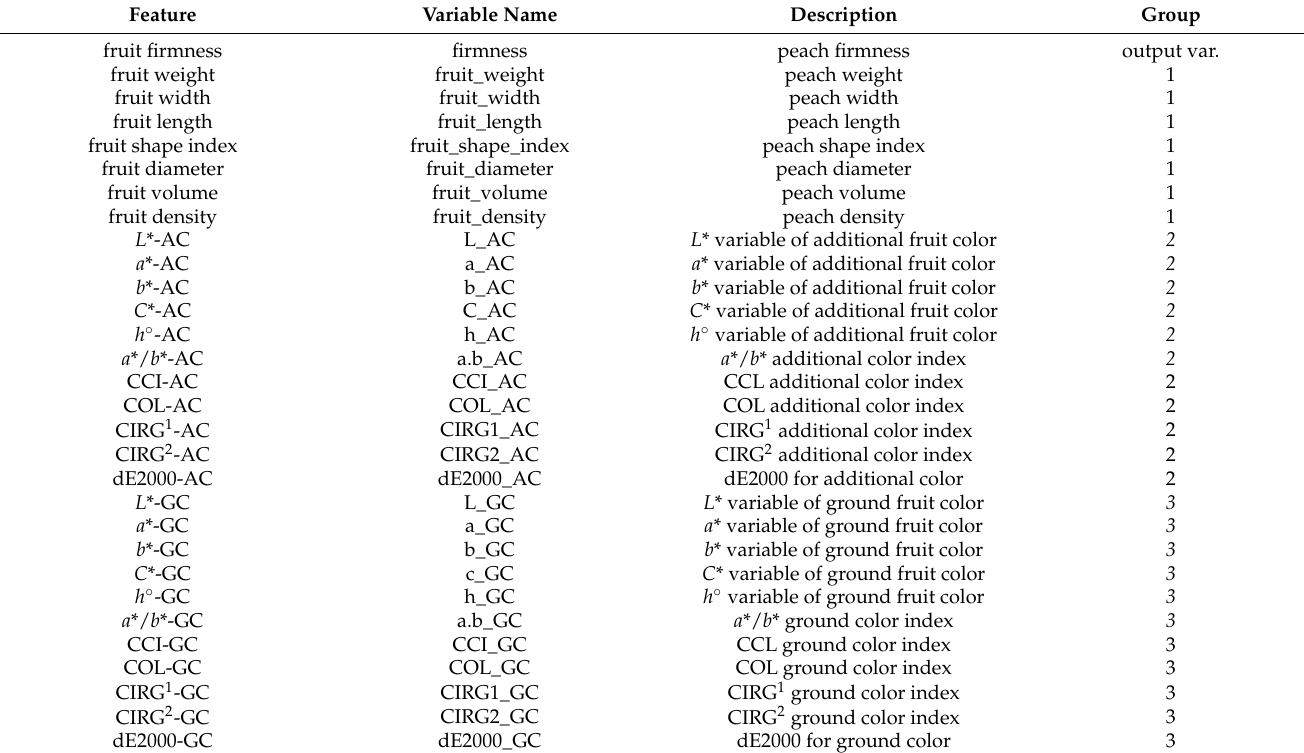
Table A1. A dataset with the list of variables it contained before the dimension was